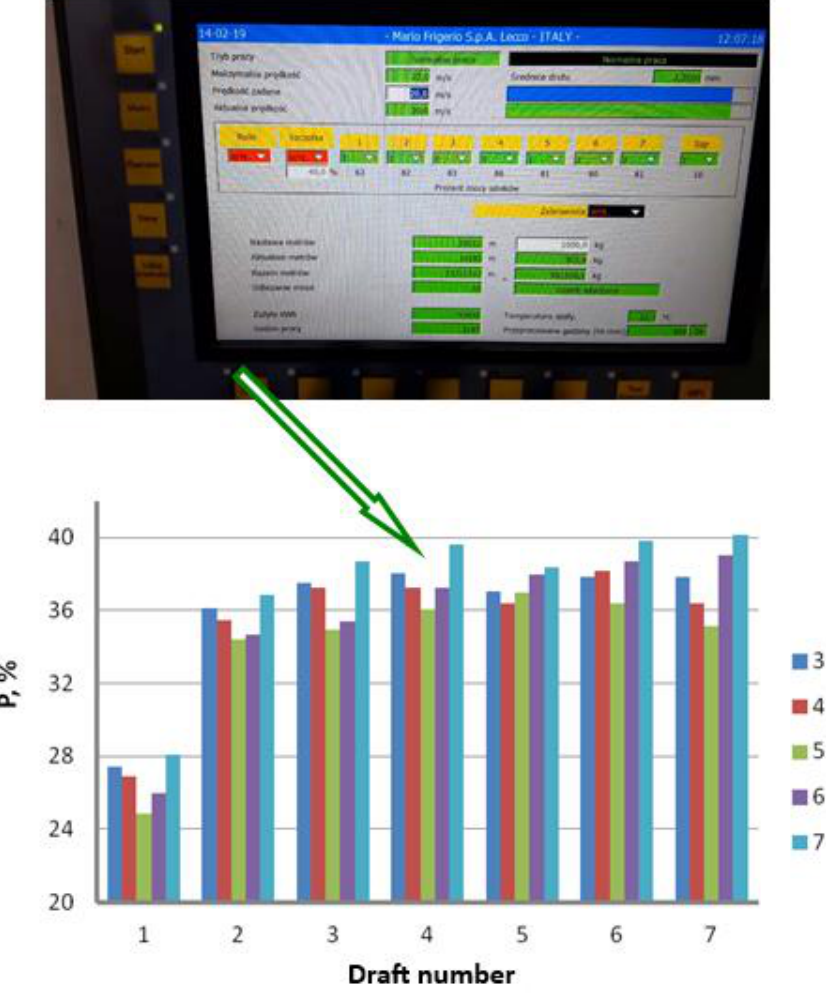
Figure 7. Control panel of the Mario Frigerio machine and percentage load of the engines P in respective drafts for the wires drawn with the angle α = 3, 4, 5, 6 and 7 ◦ and drawing speed of 20